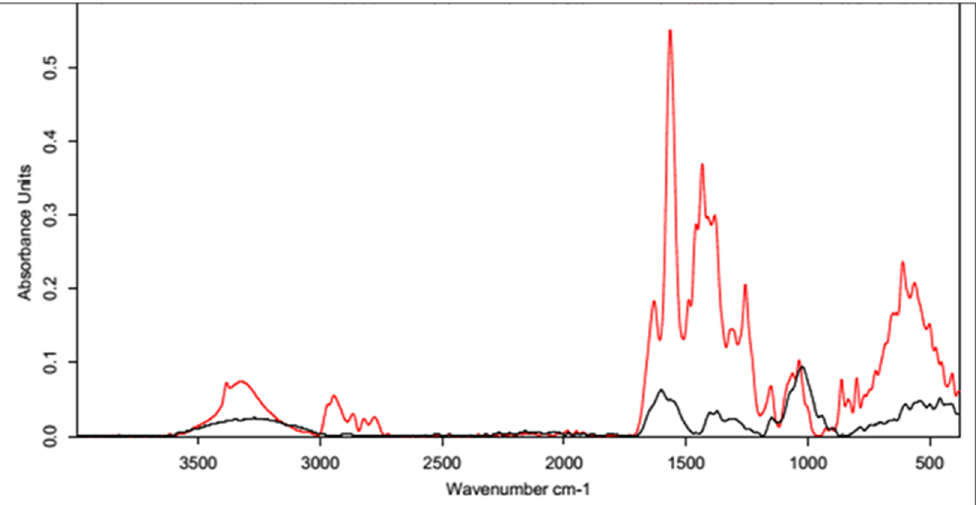
Figure 7. FT-IR spectrum of native HA (black) vs. HA cross-linked with 1,4-butanediamine (red). Cross-linking with Citric Acid